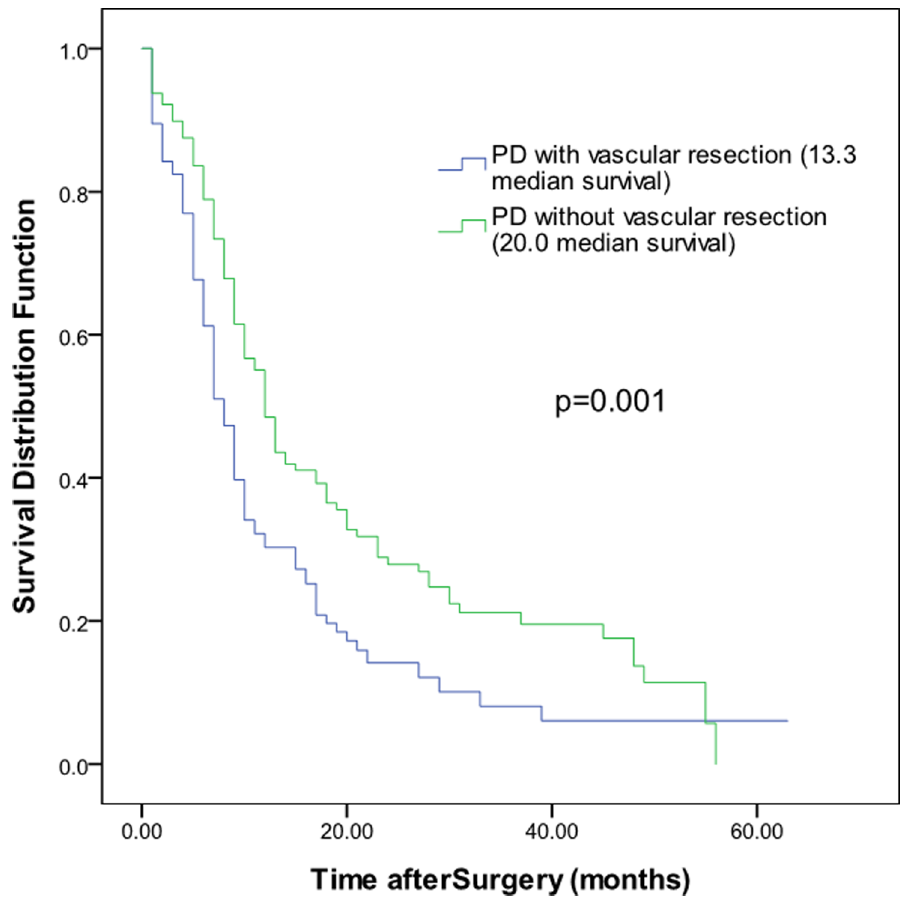
Figure 1. Comparison of the survival curves of the 119 cases treated with PD combined with vascular resection and reconstruction and those of the 447 cases treated with PD without vascular resection and reconstruction.